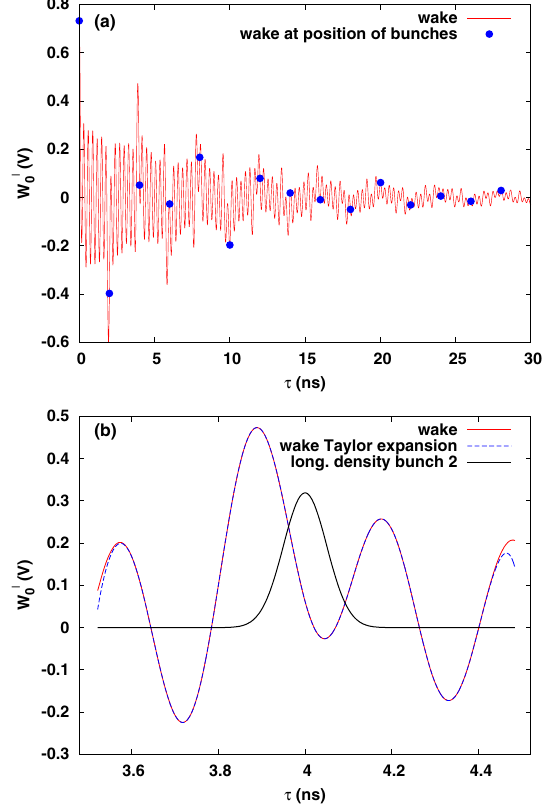
FIG. 1. Construction of the longitudinal wake force from the Taylor expansion of the wake function shown by the red line. (a) The points in blue represent the wake function evaluated at the position of bunches, separated by 2 ns. (b) Reconstruction of the wake function, shown by the dashed blue line, around the centroid of bunch m ¼ 2 with 25 terms in the Taylor expansion, necessary for the study of bunch dipole oscillations up to (cid:3) 10 σ , where σ is the bunch length (here σ ¼ 50 ps).